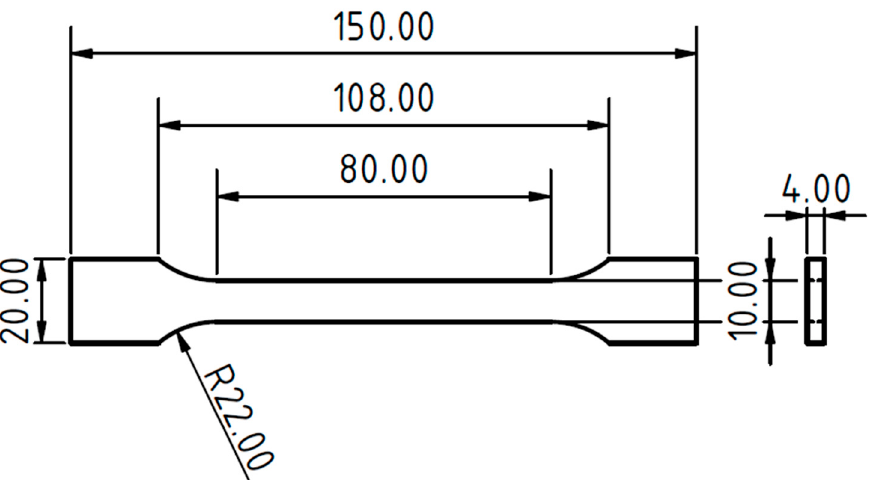
Figure 1. Test sample type 1B according to the ˇCSN EN ISO 527-2 created by 3D printing from PLA-based filament and bamboo filler.